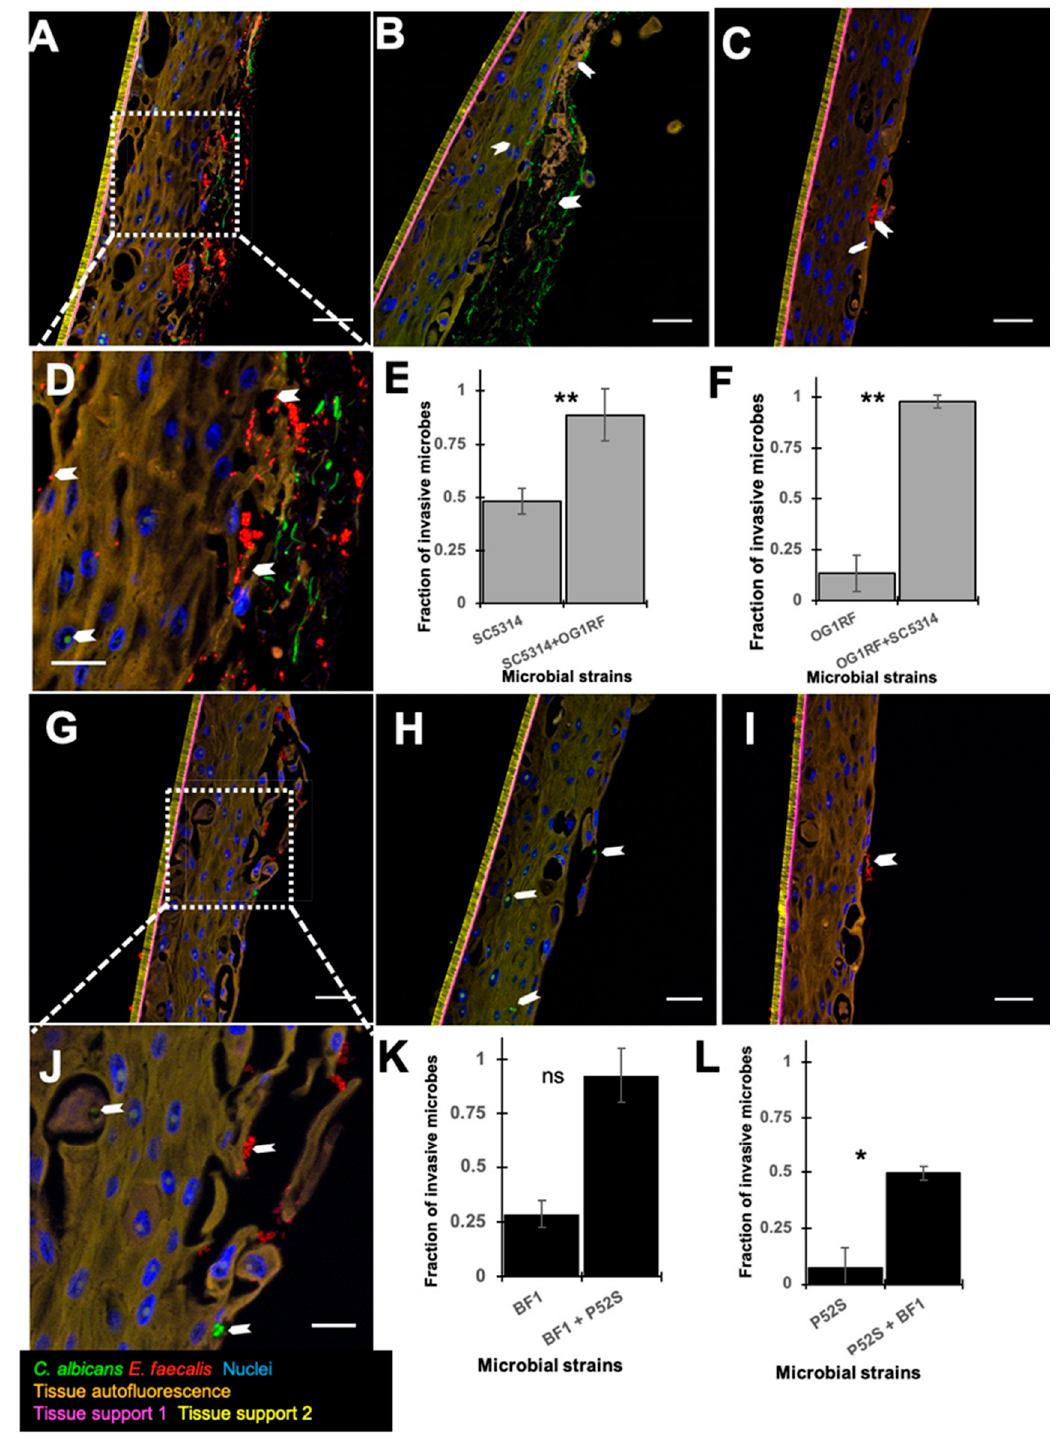
Figure 2. Analysis of microbial invasion in an in vitro organotypic oral mucosal model. All images are spectral fluorescence images. C. albicans (green) was visualized after staining with Caal probe conjugated to Alexa fluor 488 and E. faecalis (red) was visualized after staining with a EUB 338 probe conjugated to Alexa fluor 594. In the multispectral fluorescent in situ hybridisation (FISH) images, tissue autofluorescence is pseudocolored orange and tissue substrate materials are pseudocolored magenta and yellow. White arrows indicate bacterial / fungal cells that invaded into the mucosal tissue layers. ( A ) Image of co-infection model with the reference strains C. albicans SC5314 and E. faecalis OG1RF; ( B ) Image of monoculture infection with C. albicans SC5314; ( C ) Monoculture infection with E. faecalis OG1RF; ( D ) Zoomed image of region of interest within dotted box in panel A showing clear